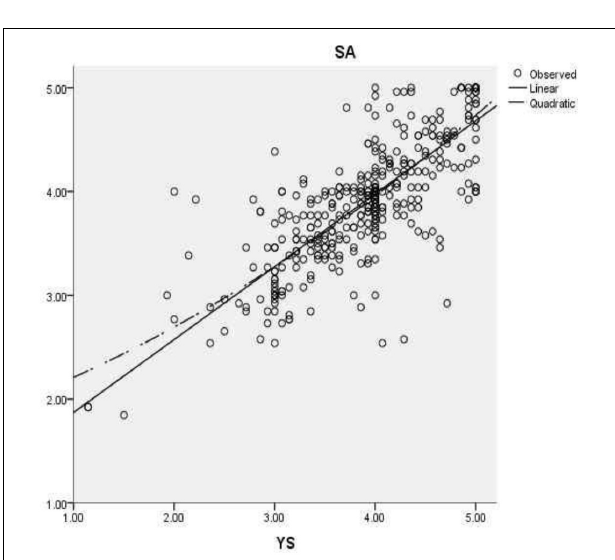
FIGURE 2 | Linear and curve fitting diagram of kindergarten supported factors (YS) to overall satisfaction (SA).